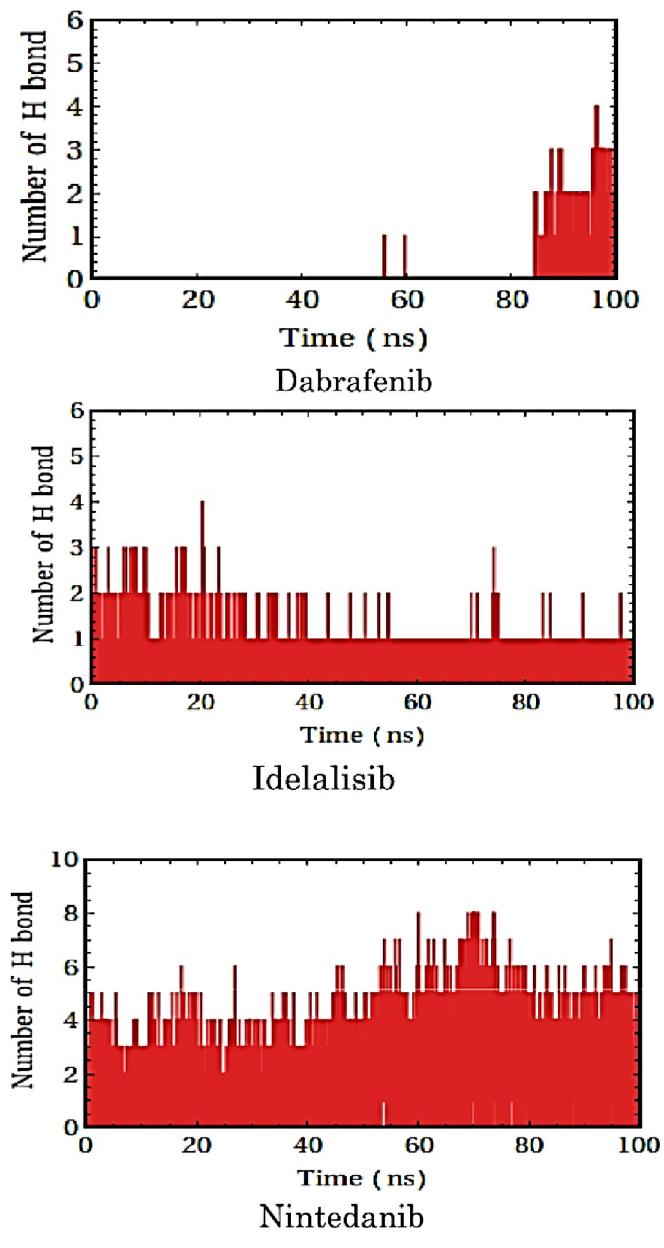
Fig 7. Hydrogen bonding in the molecular recognition of the allosteric ligands with the allosteric binding pocket of the type 1 dengue protease.